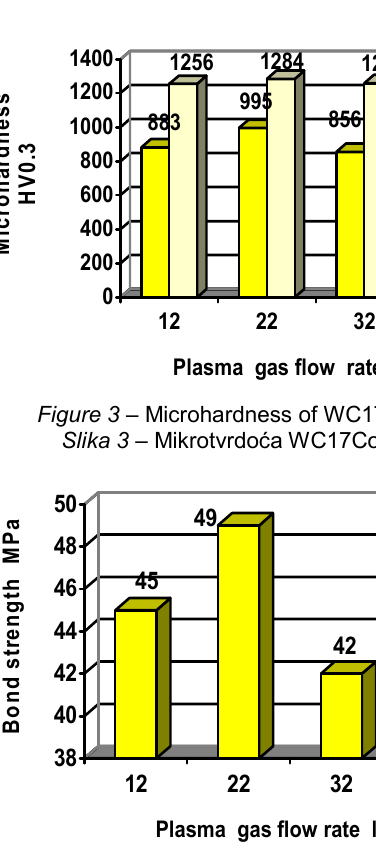
Figure 4 – Bond strength of WC17Co layers Slika 4 – Č vrsto ć a spoja WC17Co